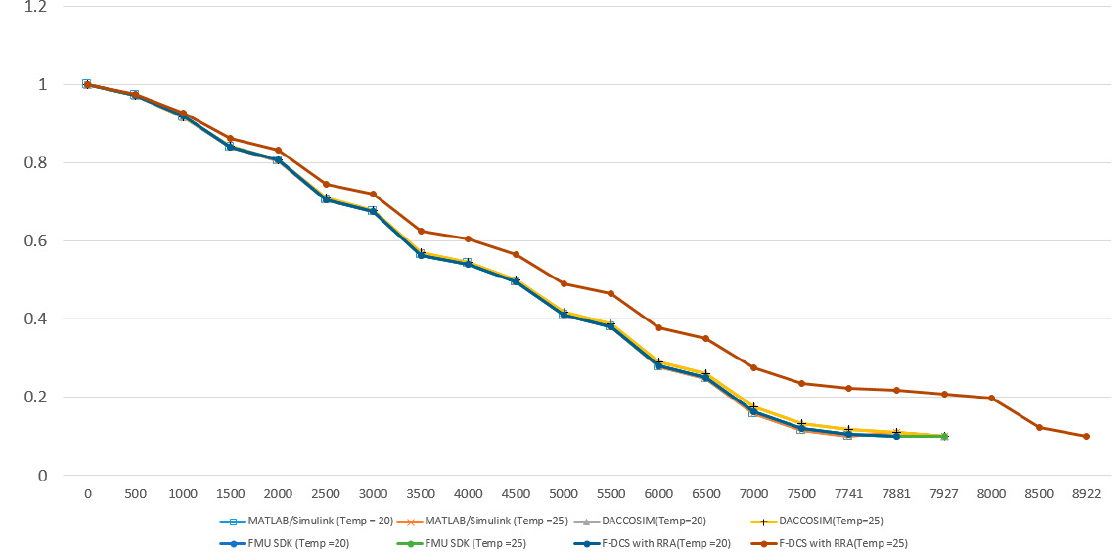
Figure 17. Test results on distributed co-simulation linked with sensor information.